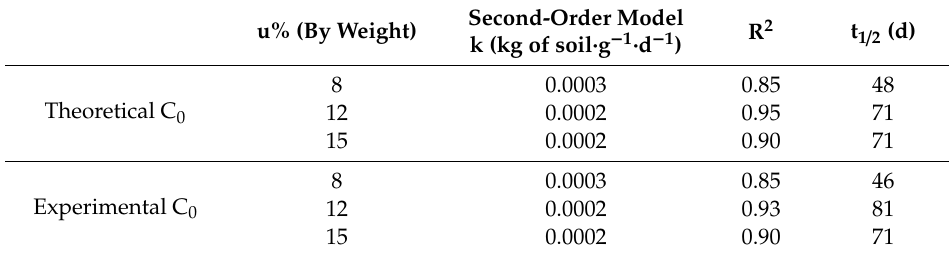
Table 7. Second-order reaction rate constant and half-life time for microcosms with C/N = 120.